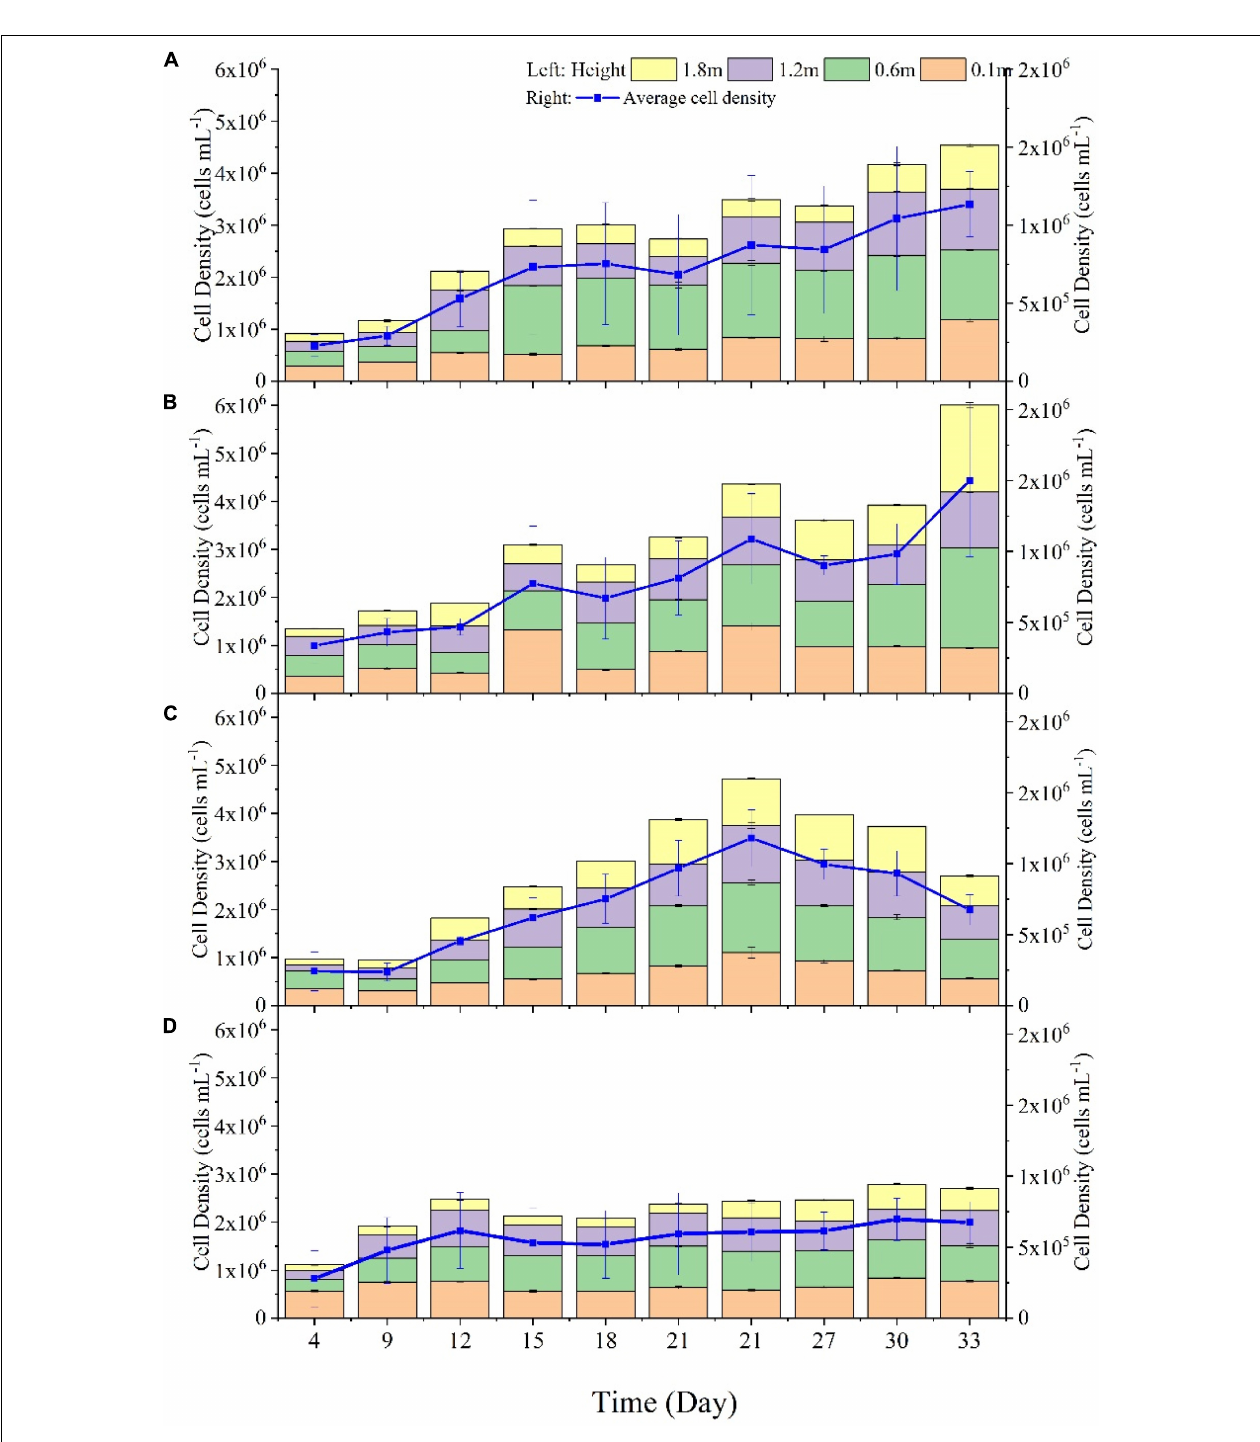
FIGURE 2 | The cell density of Microcystis aeruginosa at different water depths (1.8, 1.2, 0.6, 0.1m) under four natural light conditions: full light (A) , 2/3 amount of light (B) , 1/3 amount of light (C) , and no light (D) .